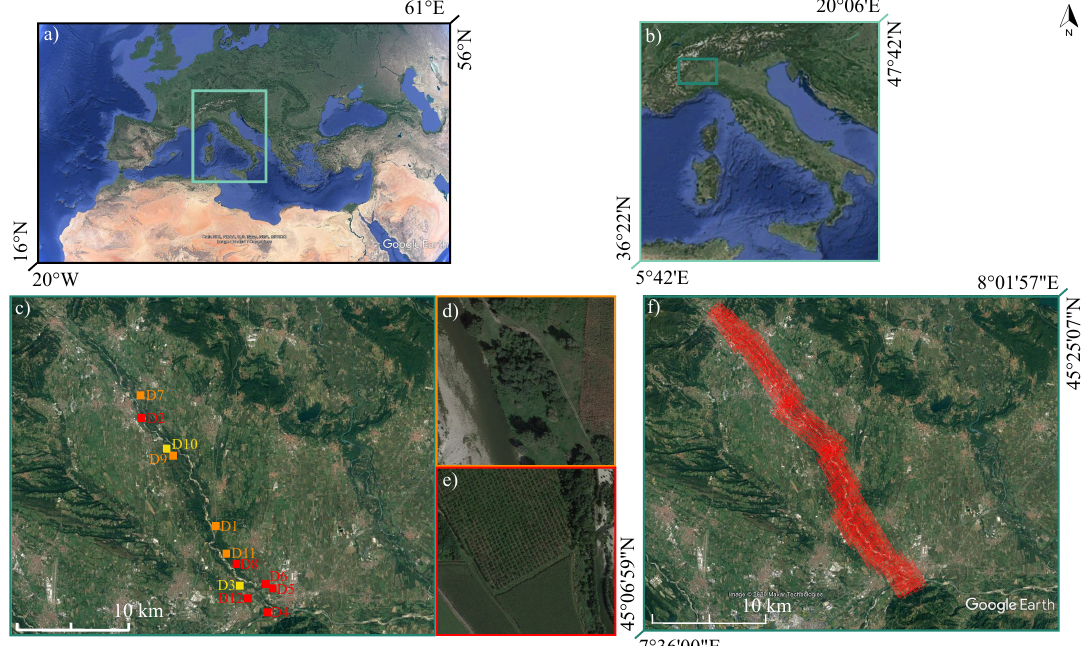
Figure 2. Contextualization of the study site from the continental ( a ) to the national ( b ) and the local ( c ) scale; ( c ) location of the twelve study sites: the red, orange, and yellow colors indicate regular, random, and mixed (only a part is regular) tree patterns, respectively. ( d ) zoom over a natural tree stand, hereinafter called D 1, and ( e ) a tree plantation, hereinafter called D 2. ( f ) flight trajectories followed during the acquisition of LiDAR data over the Orco Valley, carried out on 28 February, 2019. Source: Google